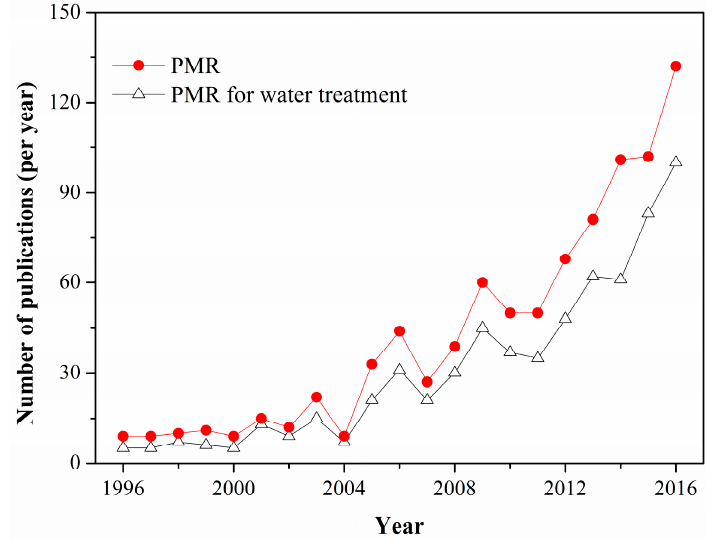
Figure 1. The number of publications on the topic of “PMRs” and “PMRs for water treatment”.